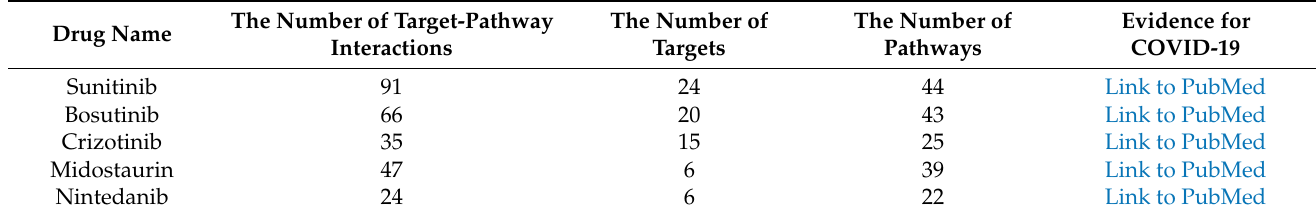
Table 3. Number of target-pathway interactions of the top five potential actionable COVID-19 repur- posed drugs. COVID19Db maps these detected top 5 drugs with the disease pathway and generates the number of targets, pathways, and target-pathway interactions. It also highlights the PubMed literature links as evidence that these top 5 drugs are already associated with or recommended for the possible treatment of COVID-19 in other in-silico or in-vitro research methodologies.